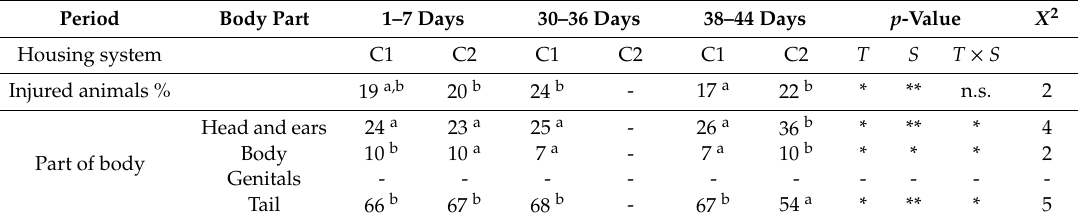
Table 3. E ff ect of housing system on skin injuries in di ff erent periods of the reproductive